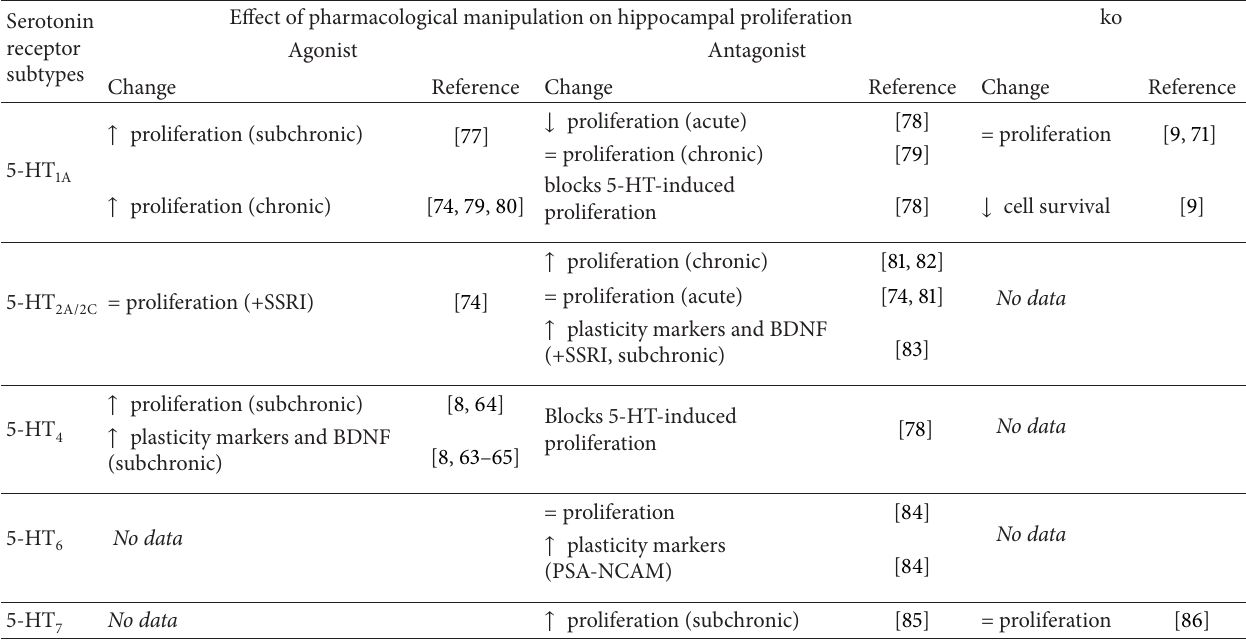
Table 1: Role of the activation and blockade of the different serotonin receptor subtypes in neural proliferation and synaptic plasticity.